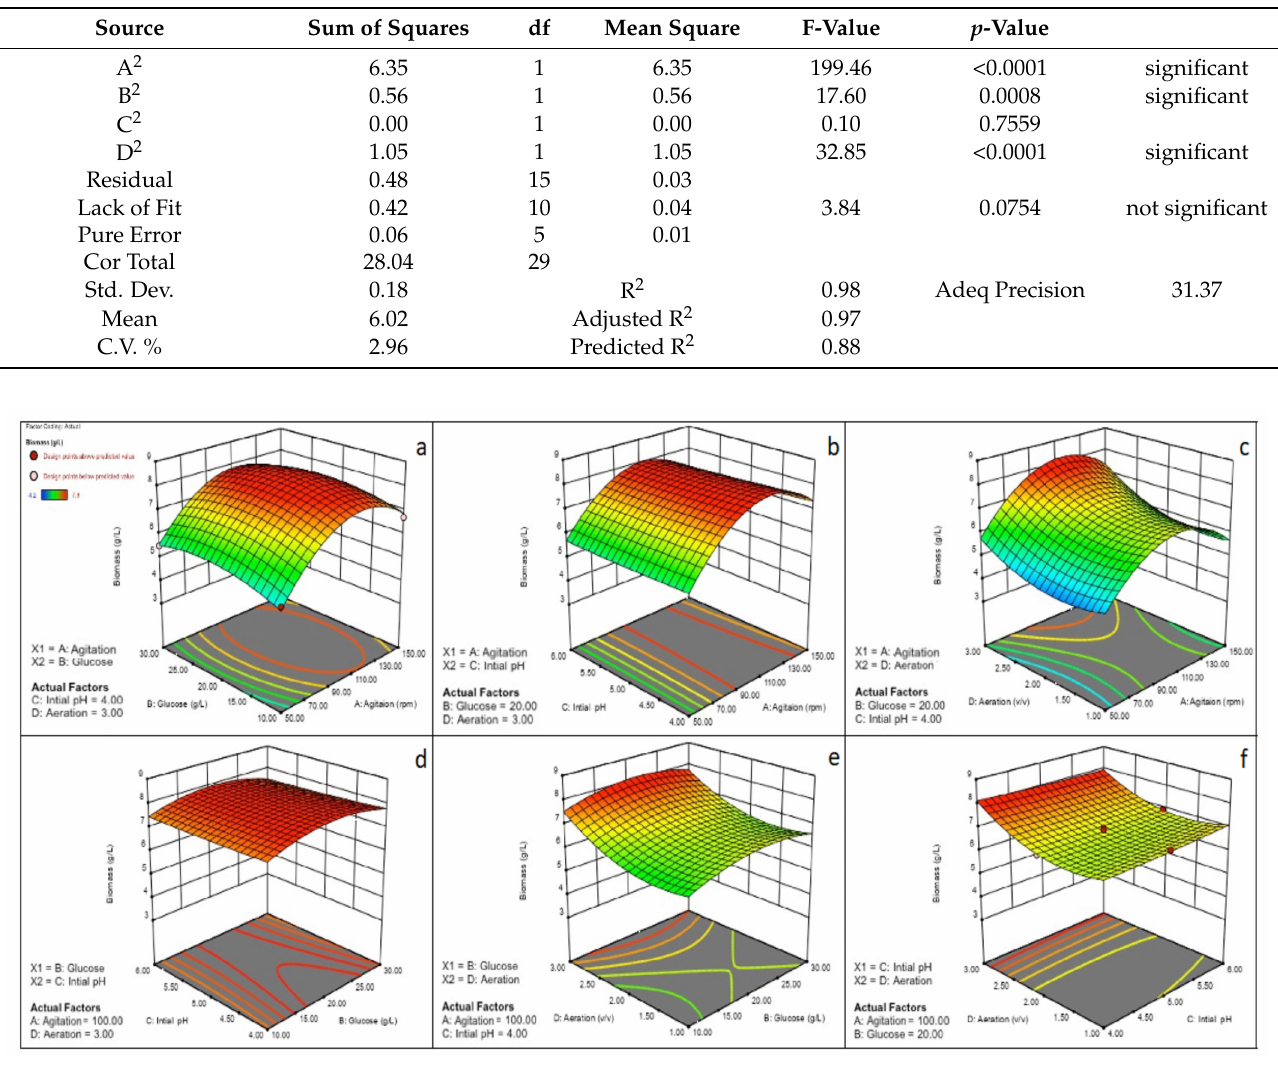
Figure 3. Response surface curve (3D plot) of mycelium biomass of G. lucidum obtained from ALSB showing the interaction between ( a ) agitation vs. glucose, ( b ) agitation vs. pH, ( c ) agitation vs.